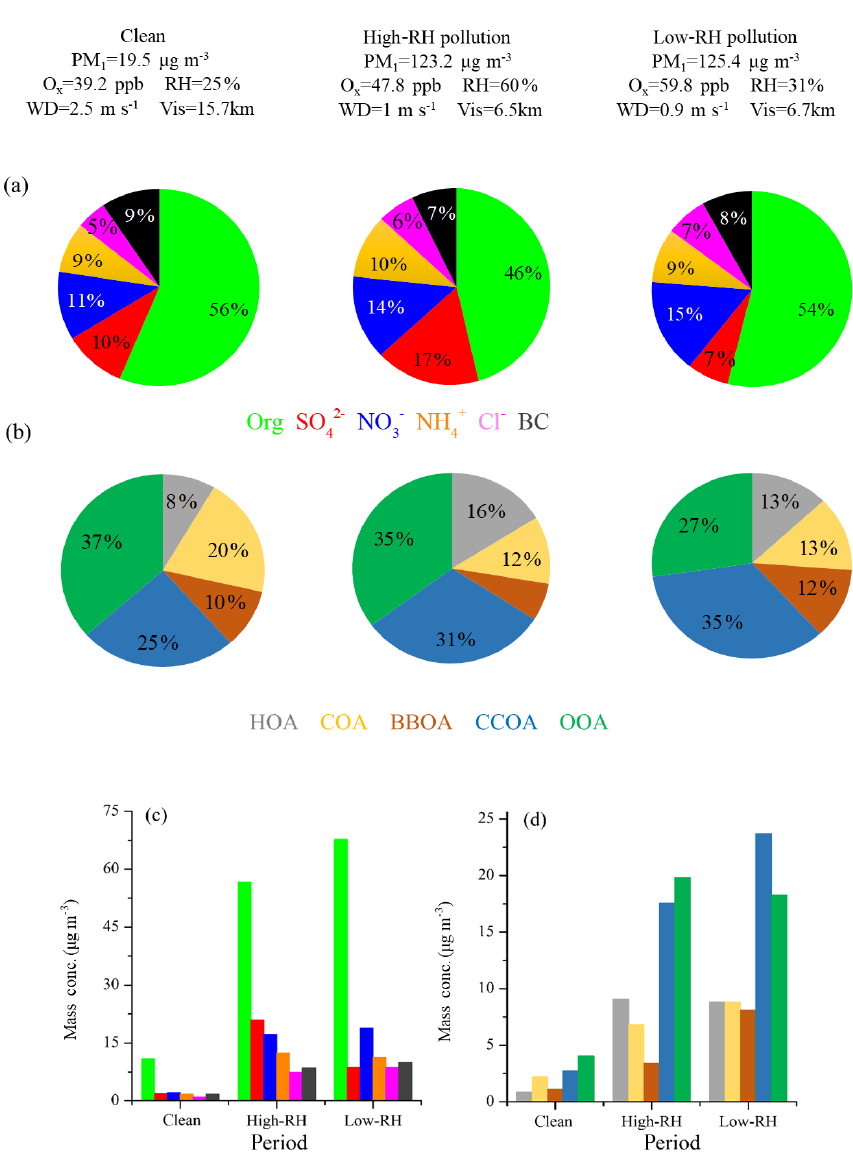
Figure 5. PM 1 chemical composition (a) and OA source composition (b) pie chart as well as the mass concentrations of PM 1 species (c) and OA sources (d) during clean, high-RH pollution and low-RH pollution periods.